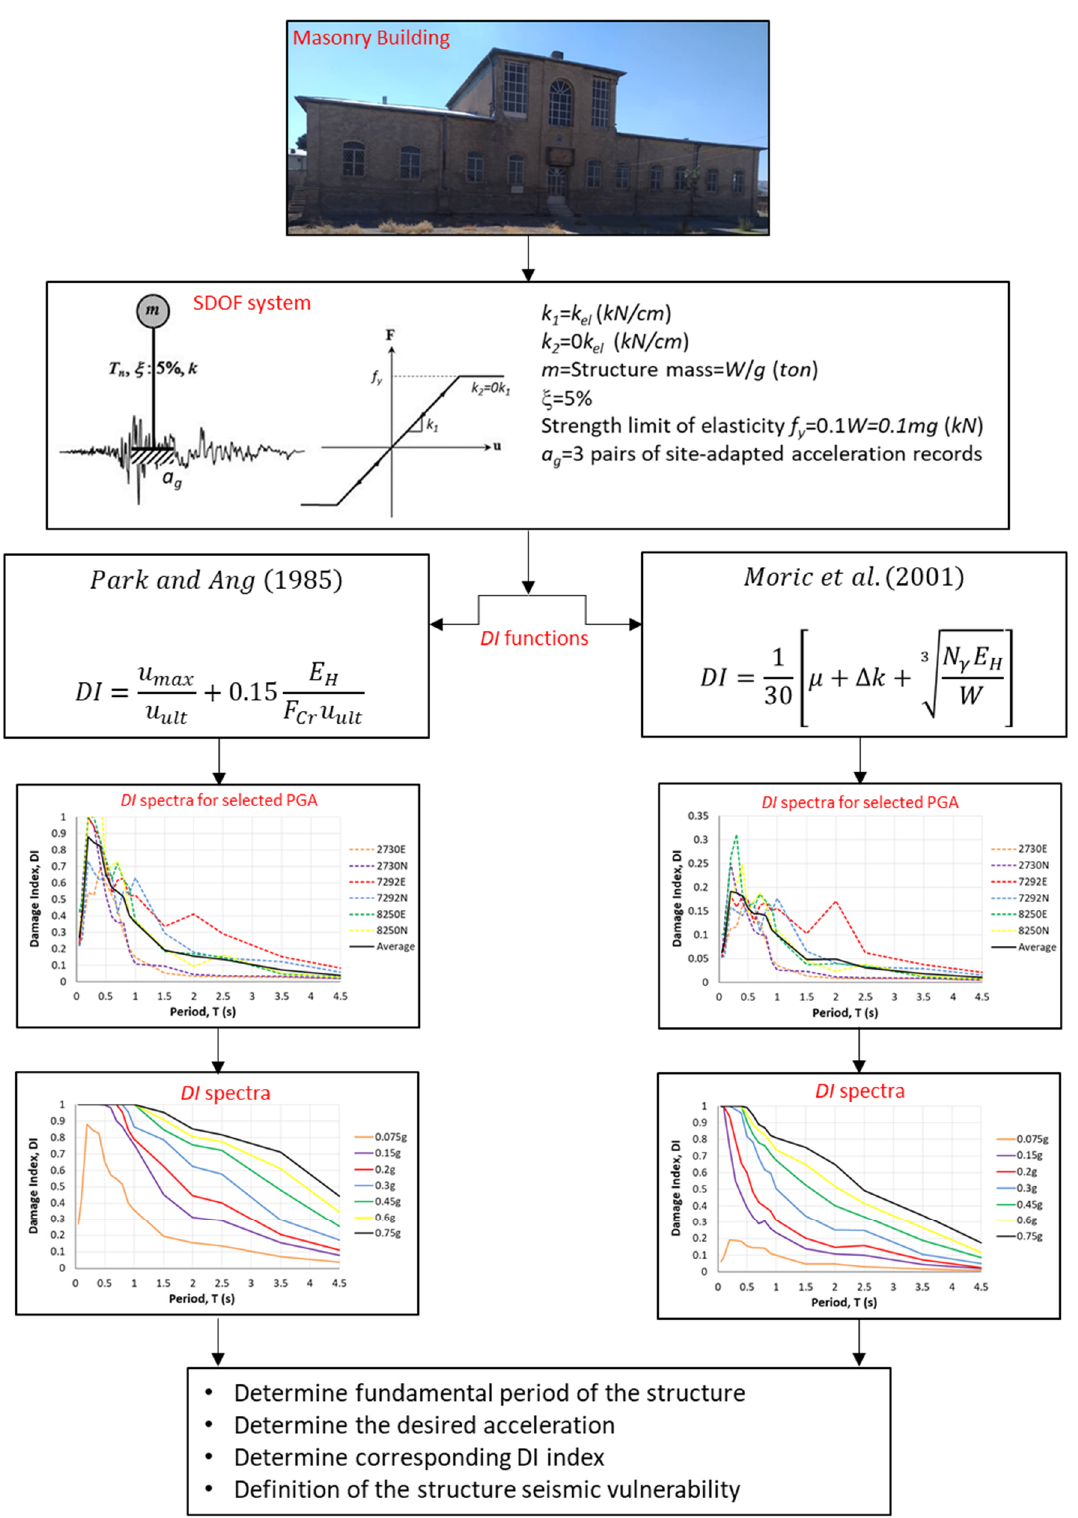
Figure 2. Methodology flowchart for DI spectra and seismic vulnerability assessment procedure